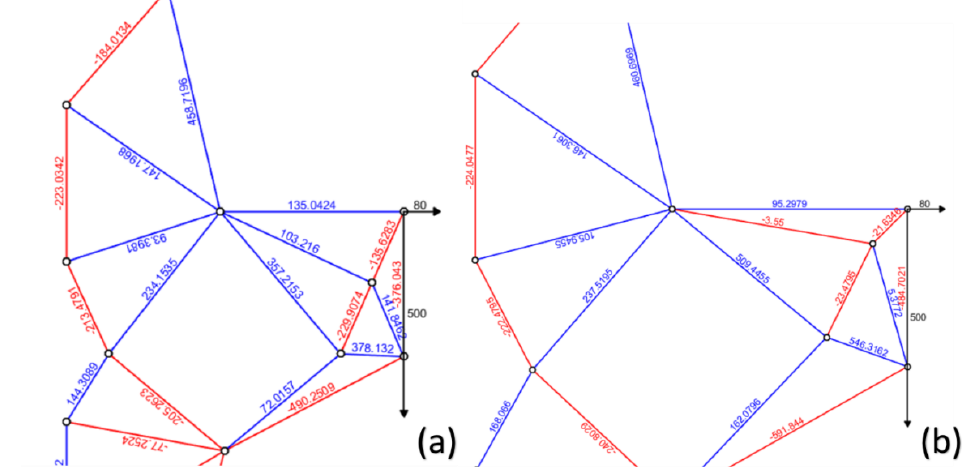
Figure 11. Load details in the rectangular corbel a) f = 50%; b) f = 40%